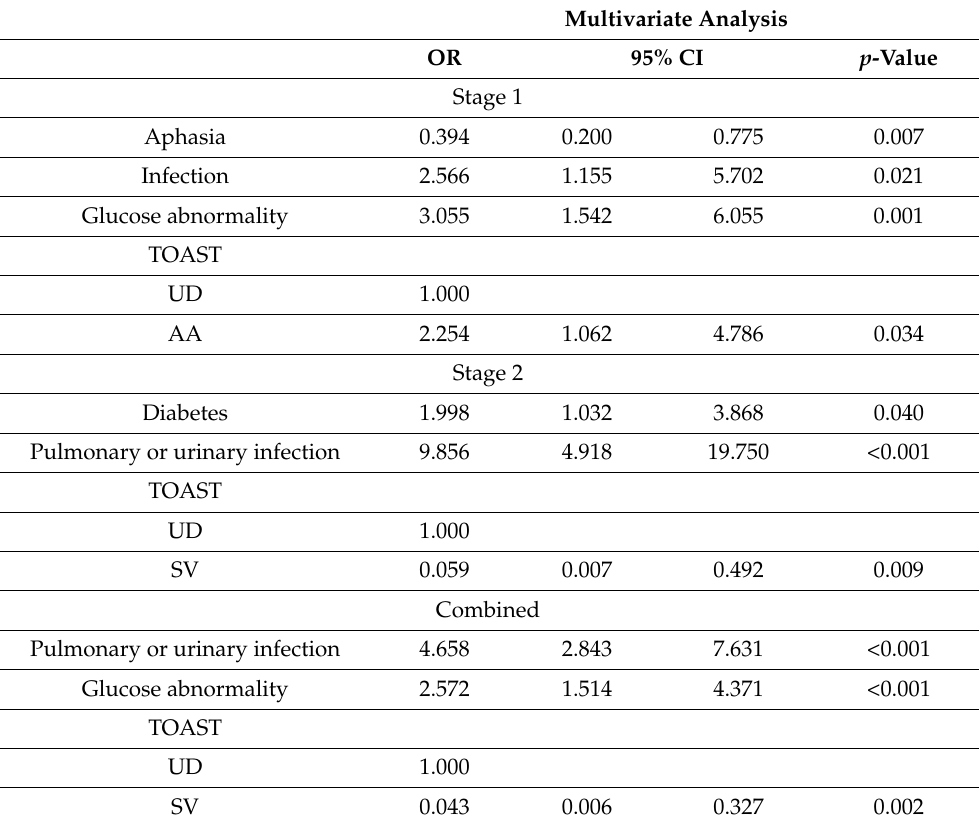
Table 3. Multivariate analysis of the factors associated with recurrent stroke in different